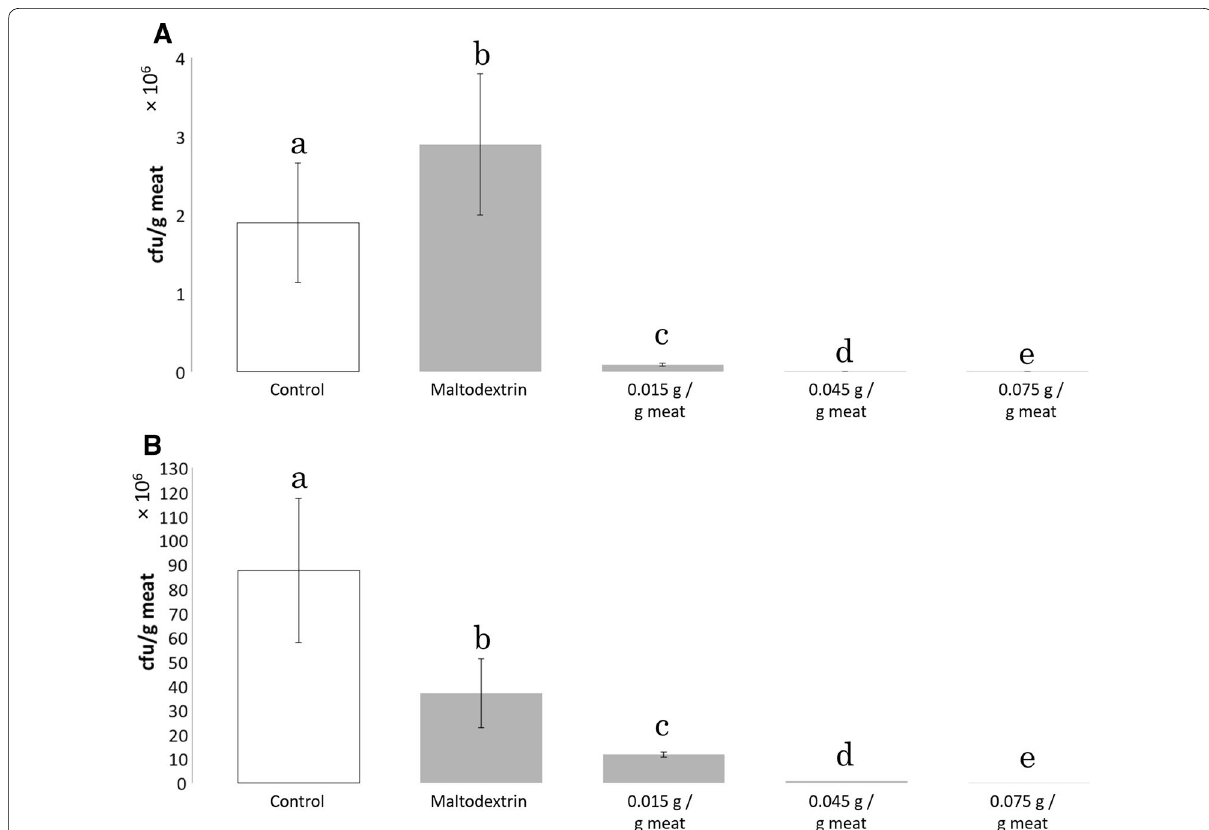
Fig. 2 Quantification of livable bacteria following storage at 4 °C. The meat strips were incubated in a refrigerator for 24 h ( A ) and 96 h ( B ). Follow- ing homogenization of the sample, dilution and plating, the plates were incubated for 48 h at 21 °C before quantification of CFU/g meat. Different letters denote significant differences among the tested concentrations (P <